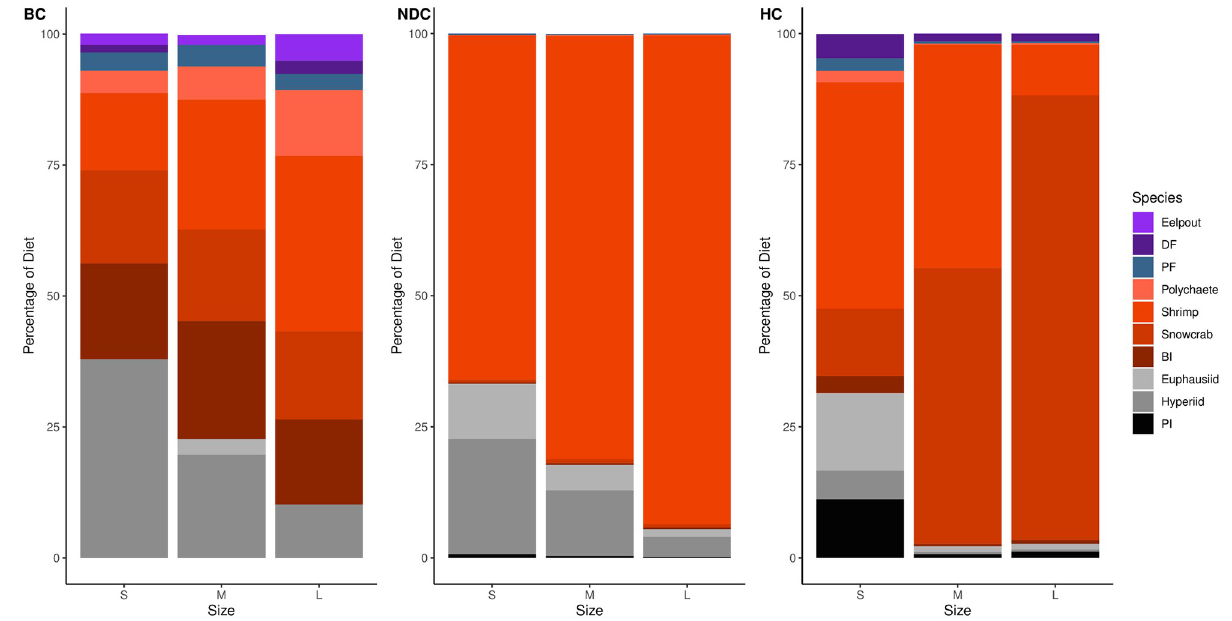
Fig 4. Atlantic cod diet composition percentages as determined from isotope mixing models. This figure is divided by predator size category (S for small, M for medium, L for large, see Table 2) and region (BC for Bonavista Corridor, NDC for Notre Dame Channel, HC for Hawke Channel). Prey taxa abbreviations are defined in Table 1.